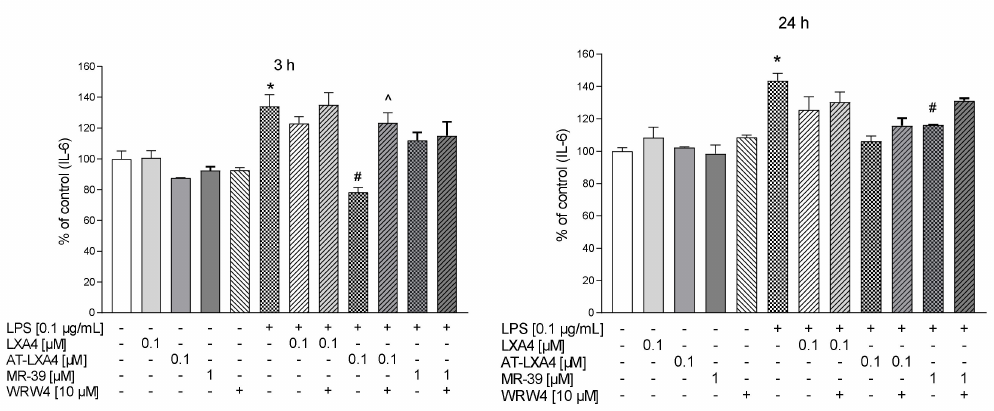
Figure 9. The impact of LXA4 and AT-LXA4 and MR-39 on IL-6 production in rat microglial cultures. The cells were pretreated for 30 min with the FPR2 antagonist WRW4 (10 µ M). After that, LXA4 (0.1 µ M), or AT-LXA4 (0.1 µ M), or MR-39 (1 µ M) was added for 1 h, and then the cells were stimulated for 3 h or 24 h with lipopolysaccharide (LPS; 0.1 µ g/mL). Control cultures were treated with the appropriate vehicle. The data are presented as the mean ± SEM percentage of the control (vehicle-treated cells) of independent experiments, n = 2–5 in each experiment. * p < 0.05 vs. the control group, # p < 0.05 vs. the LPS group, ˆ p < 0.05 vs. the agonist + LPS group. LXA4: lipoxin A4; AT-LXA4: aspirin-triggered lipoxin